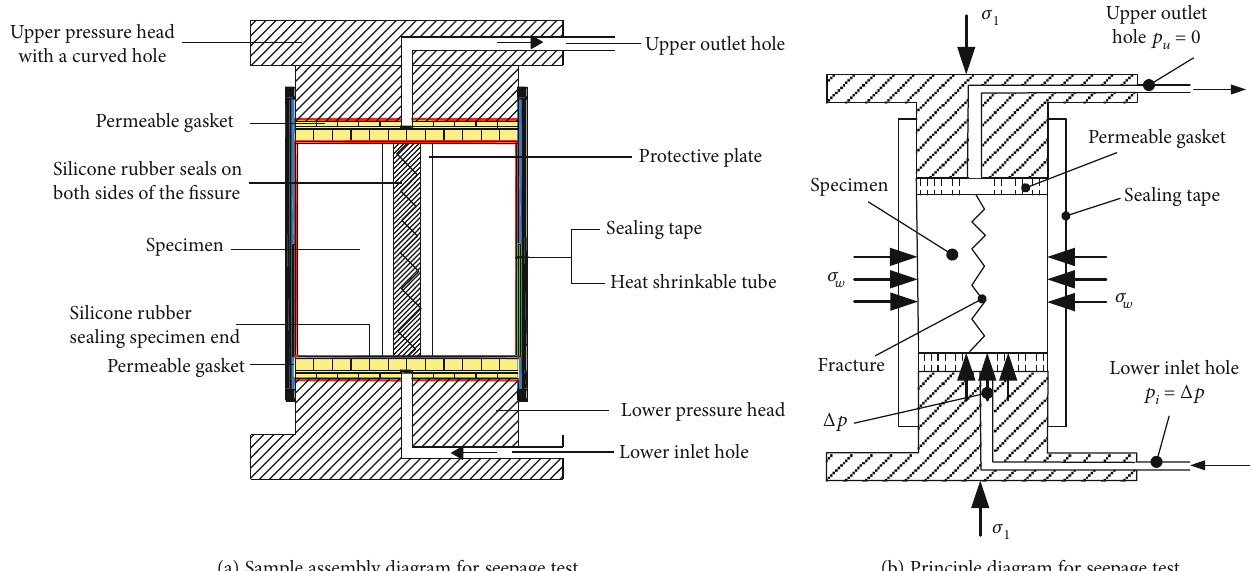
Figure 6: Sample assembly and principle diagram for seepage test.